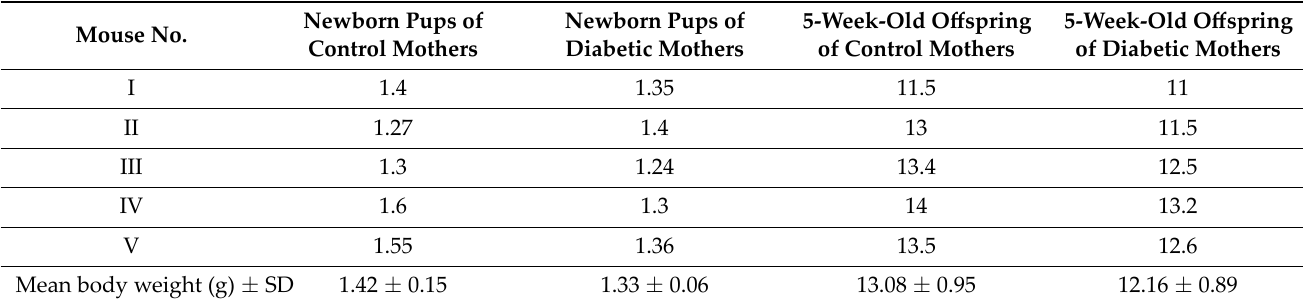
Table 2. Offspring of Mothers with Untreated Diabetes. Blood Glucose Level (mg/dL) Average Level of Blood Glucose (mg/dL) Number of Mice Control mother 110 ± 2 Diabetic mothers 260 ± 20 ** a Offspring of Control mother Offspring of diabetic mother 165 ± 4 ** a p ≤ 0.01 ** high significant variation.